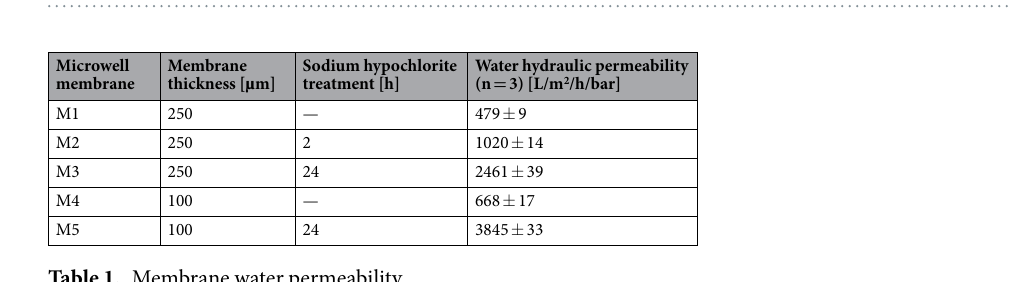
Figure 3. Transport characteristics. ( A ) Clean water flux vs. pressure for 250 µ m thick membranes, ( B ) Clean water flux vs. pressure for 100 µ m thick membranes, ( C ) MIN6 aggregates insulin secretion through the membrane in response to a high glucose concentration. Error bars indicate standard deviation (n = 3).